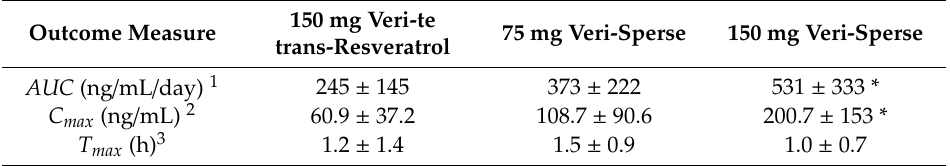
Table 2. Trans-resveratrol-glucuronide absorption